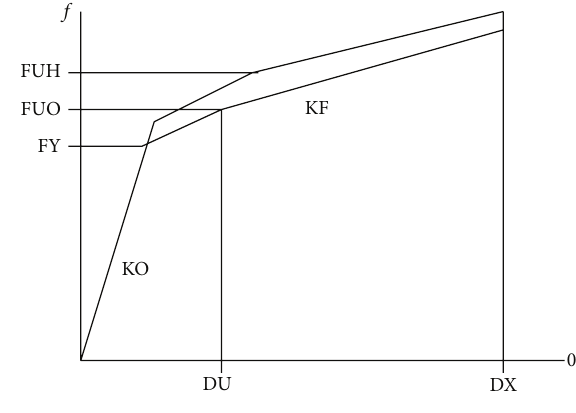
Figure 10: Trilinear curve for